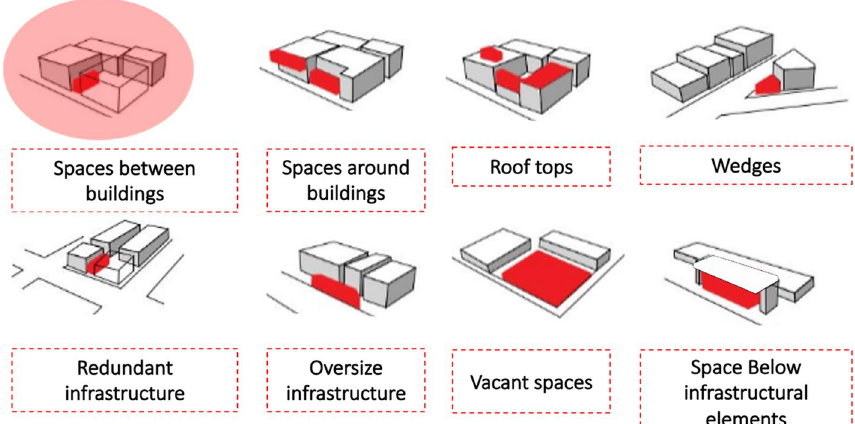
Fig. 1 Classification of residual spaces and space between building as scope of